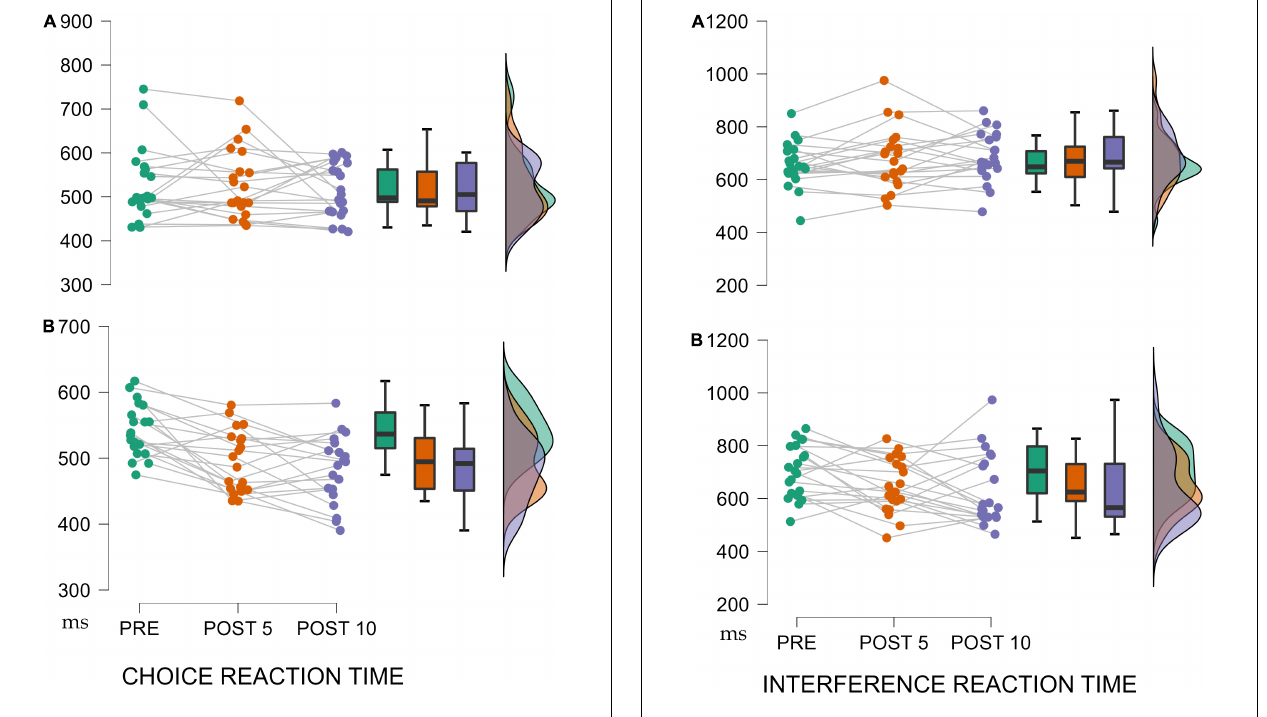
FIGURE 4 | (A) Control Group. (B) Experimental Group. Evolution of InT during the training process. At the beginning of the study (PRE), after 5 weeks of supervised training (POST 5) and after another 5 weeks of online training during quarantine (POST 10). Significant results shown with p -values are for the experimental group. Data are shown as mean ± standard